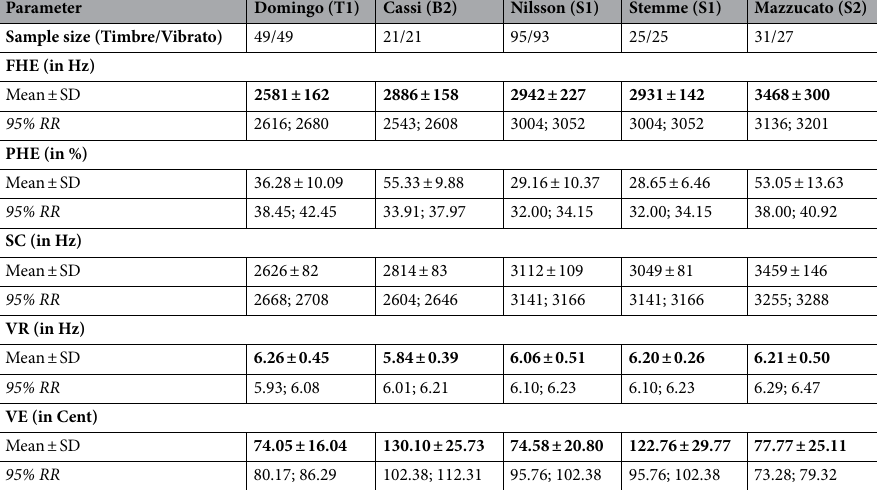
expressiveness of FHE becomes evident in Fig. 1, where Domingo and Cassi were compared. It demonstrates the individual progression of sound energy within the specified frequency band from 2000 to 3600 Hz. The black bar indicates where 50% of the energy was reached, representing the individual FHE value. The analyzed sound samples were taken from the role of Rodolfo from the opera Luisa Miller by Verdi (Domingo) and the role of Malatesta from the opera Don Pasquale by Donizetti (Cassi). Figure 2 shows the correlation heat map between all investigated vocal parameters, which revealed high cor- relations between FHE, PHE, and SC. In ensemble learning, similar features used as input for the base learner can impair the robustness of the model 23 . Since the characteristics defined by FHE and PHE are practically the same (i.e. frequency or position of half energy), only one of both parameters needed to be retained. From Eq. (2) (cf. Materials and Methods) it can be deduced that the ratio of the SD to the mean of PHE is always greater than